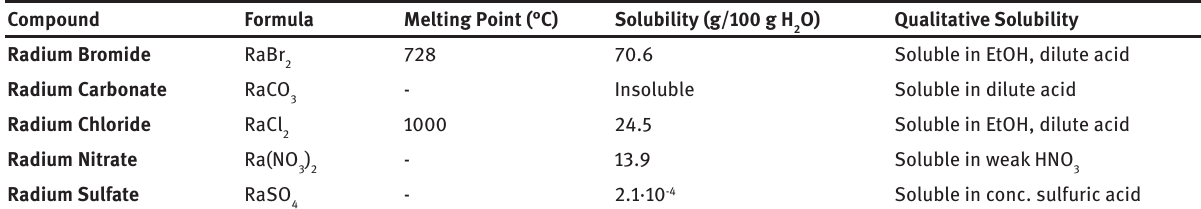
Table 1: Radium compounds and their basic properties [16-19].